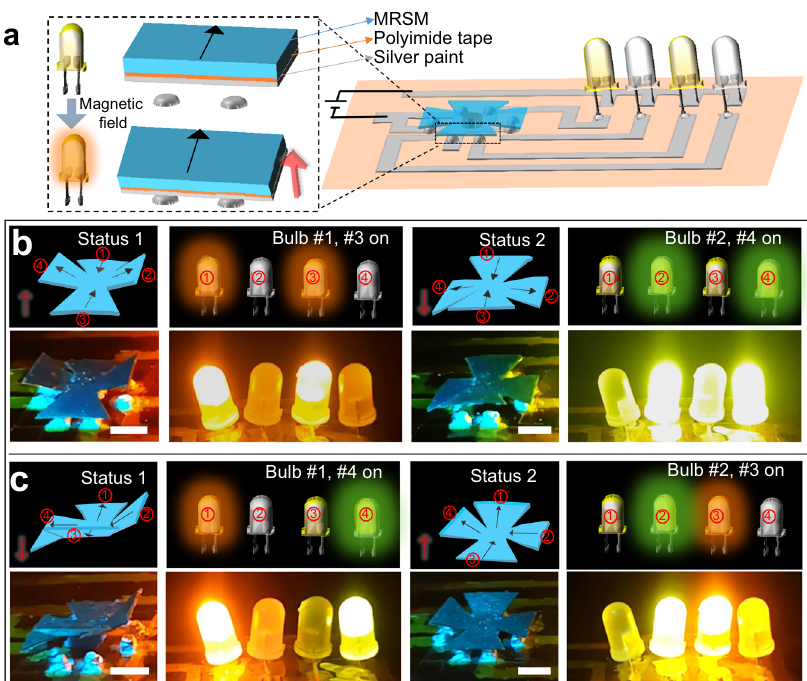
Fig. 5 Functional demonstration of MRSM as a multistate electrical switch. a Schematic of a circuit made of a recon fi gurable MRSM switch to control the LEDs. b , c experimental results showing multistate switching of the MRSM switch. The magnetic switch is actuated by a magnetic fi eld of 150 mT, which is perpendicular to the device as indicated by the red arrow. Scale Bars: 5 mm.